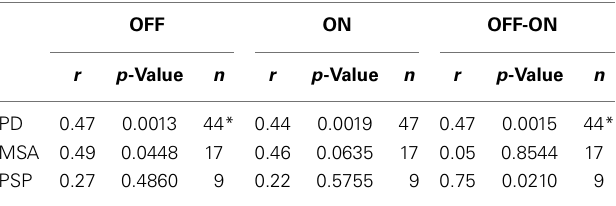
Table 4 | Correlation between PLM MT(s) and UPDRS III for each diagnosis.